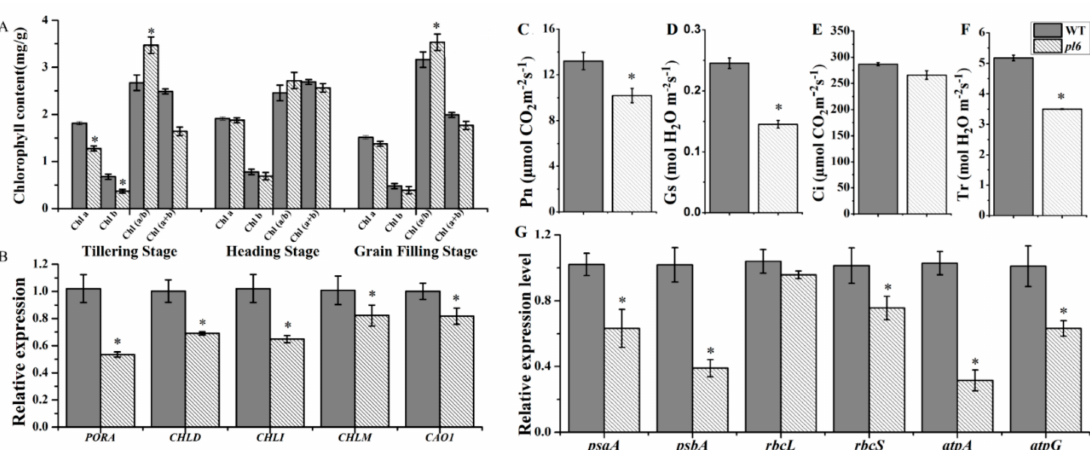
Figure 5. Photosynthetic pigment contents, photosynthetic parameters and the expression of relative genes between the WT and the pl6 mutant. ( A ) Pigment contents in leaves at the tillering and heading, grain filling stage; ( B ) The expression prototype of pigment metabolism genes at the late tillering stage; ( C ) Photosynthetic rate (Pn); ( D ) Stomatal conductance (Gs); ( E ) Intercellular CO 2 concentration (Ci) and ( F ) transpiration rate (Tr); ( G ) Expression analysis of genes associated with photosynthesis. Asterisks indicate the statistical significance levels according to Tukey’s test: * p < 0.05. All values represent the mean ± SD of three